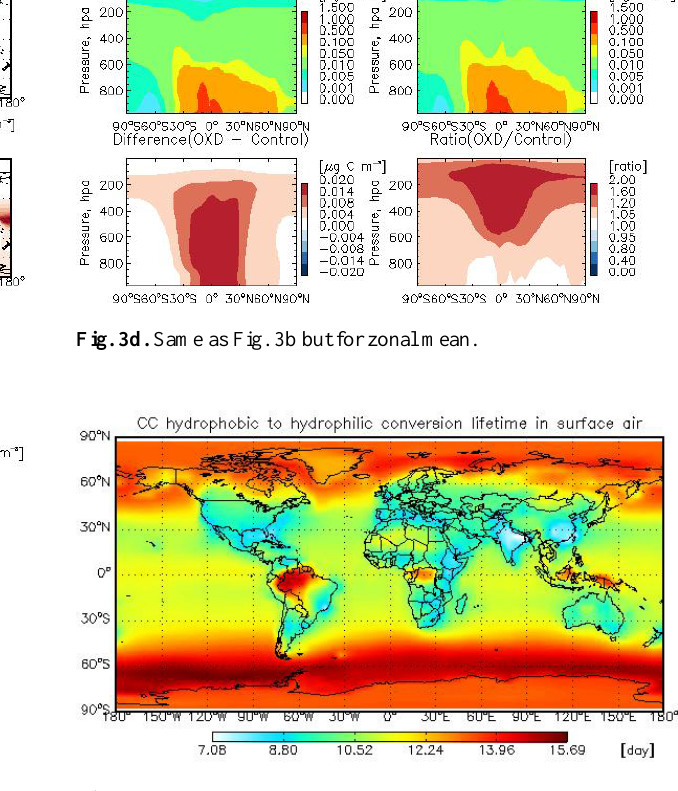
Fig. 4a. Model calculated hydrophobic to hydrophilic con- version lifetime for carbonaceous aerosols in surface air by condensation-coagulation aging scheme. CC (hereinafter) repre- sents condensation-coagulation aging